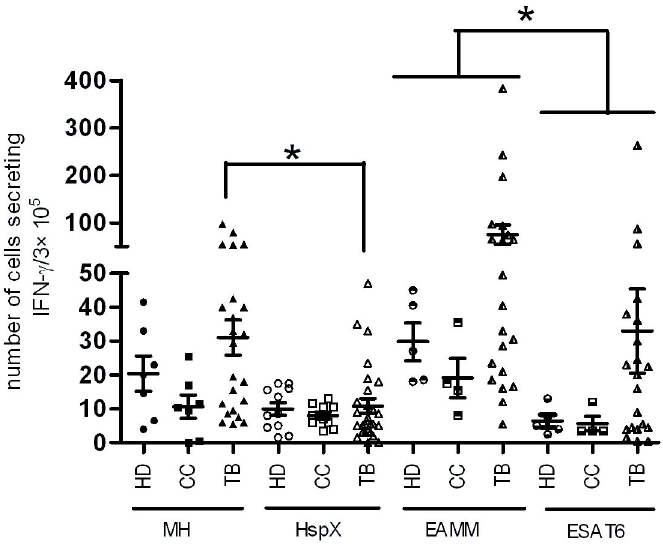
Figure 4. IFN-γ response profiles to recombinant proteins MH, HspX, EAMM and ESAT-6 in different groups of donors. Healthy BCG-vaccinated donors (HD, n = 5-11), close contacts (CC, n = 4-10) and active TB patients (TB, n = 21-28) were recruited. IFN-γ secreting cells were analyzed using human IFN-γ ELISPOT kits. Freshly isolated PBMCs from these subjects were plated in duplicate at 3 ×10 5 cells per well in 96 spot and incubated with the recombinant proteins (10 µg/ml or 20 µg/ml) for 48 h at 37°C. Data are shown as mean ± SD. * p <